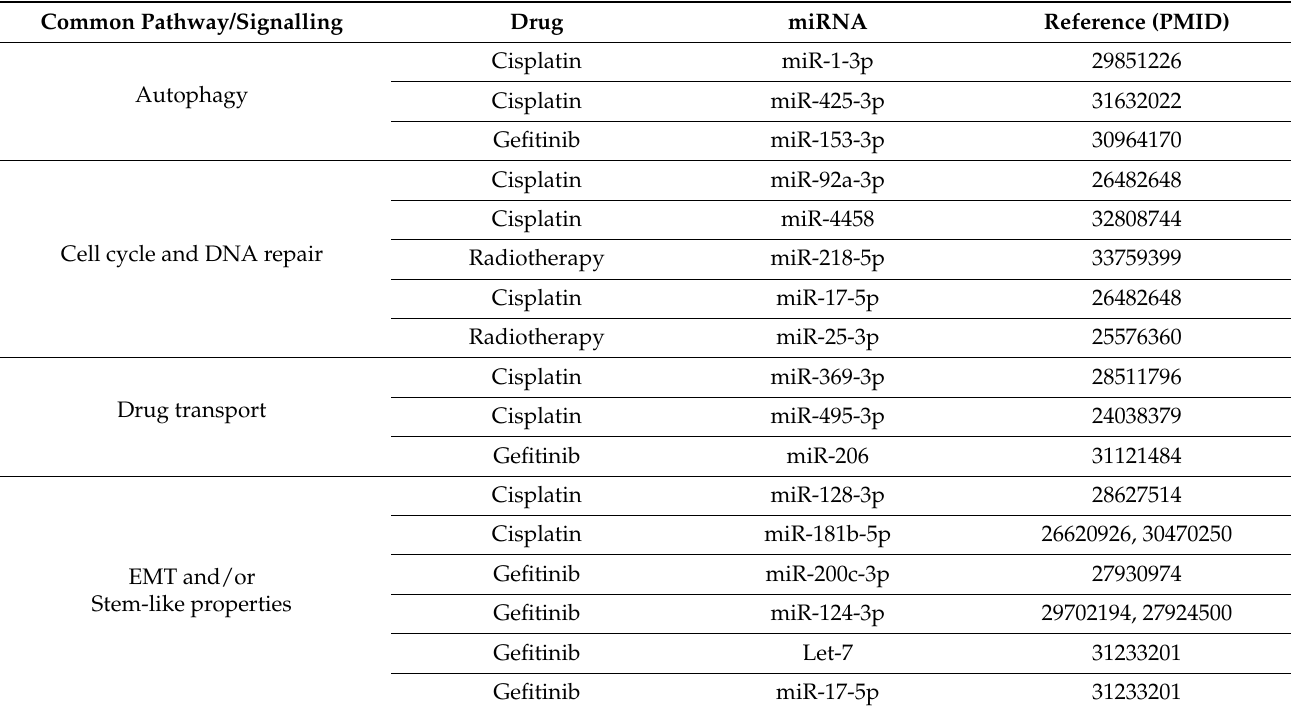
Table 1. List of miRNAs implicated in common resistance mechanisms to drugs (“Drug”) as well as modulating shared pathways/signalling cascades (“Common Pathway/signalling”). MicroRNA ID (“miRNA”) likewise pubmed reference ID (“PMID”) is also